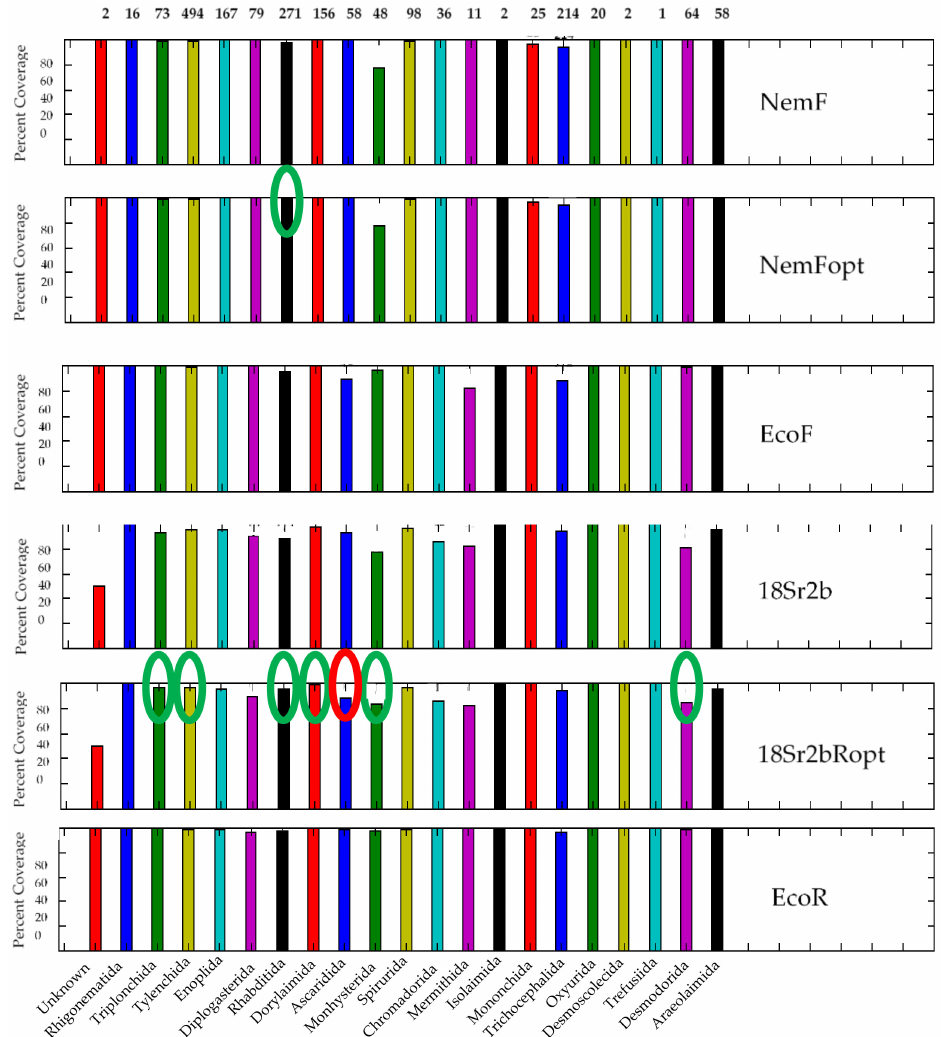
Figure 3. In silico evaluation of the taxonomic coverage of each primer NemF [14], NemFopt (this study), EcoF (this study), 18Sr2b [10], 18Sr2bRopt (this study), and EcoR (this study) by PrimerProspector [30] against our 18S rRNA sequence database. Taxonomic level: Order. Green and red circles refer to, respectively, a better or worse taxonomic coverage for the annotated nematode Order by the adapted primer compared to the original one (NemFopt compared to NemF and 18Sr2bRopt compared to